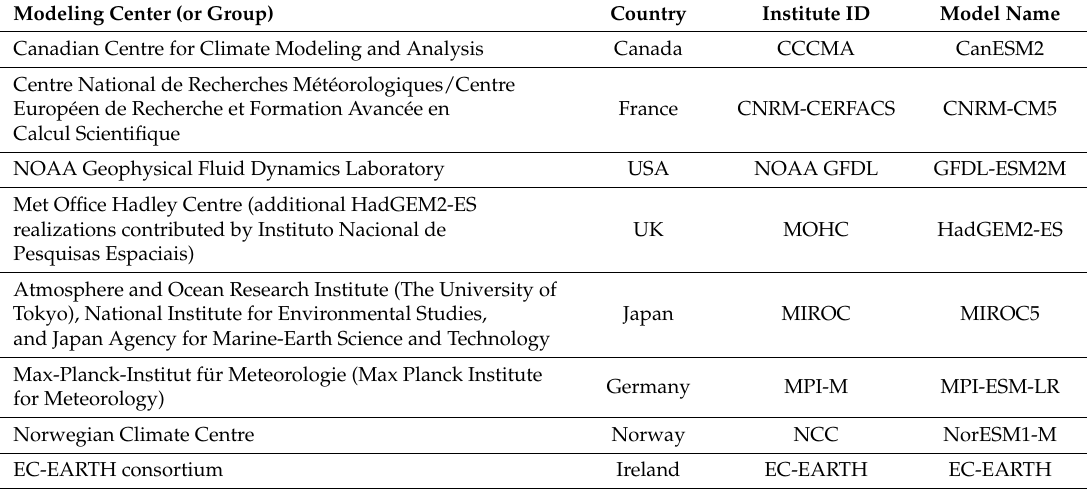
Table 1. List of CMIP5 Global Climate Models (GCMs) considered in the